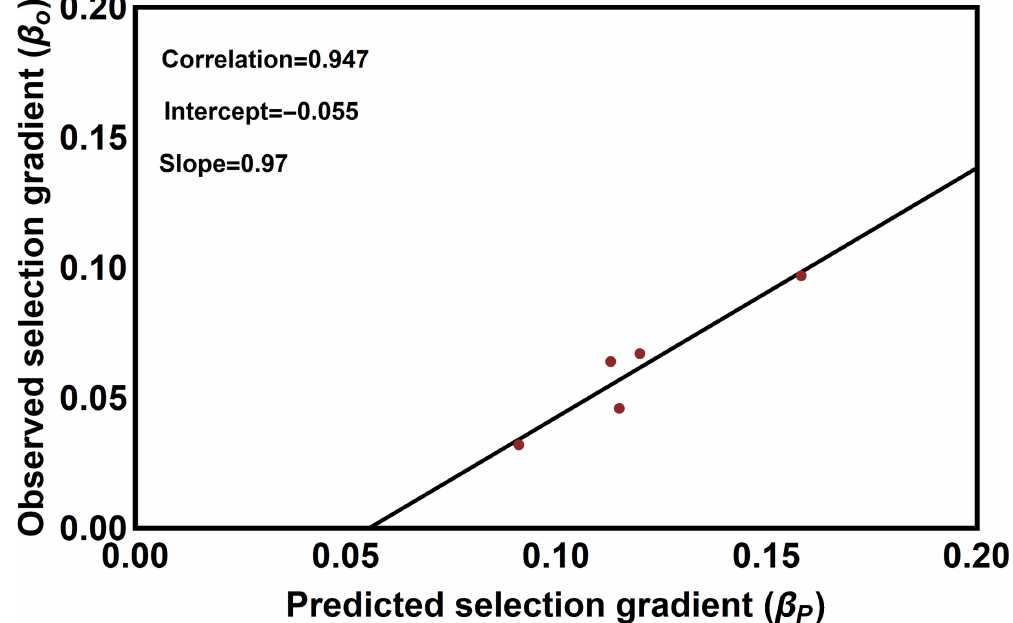
Fig 6. Standardized biotic selection gradients acting on pericarp thickness predicted by our ABC method plotted against their independently measured values. Predicted selection gradients were calculated for the five populations for which Toju and Sota [34] reported significant selection gradients and which belonged to a single clade. Predicted selection gradients were calculated by conducting a simulated phenotypic selection analysis in each population based on the modal parameter values of the posterior